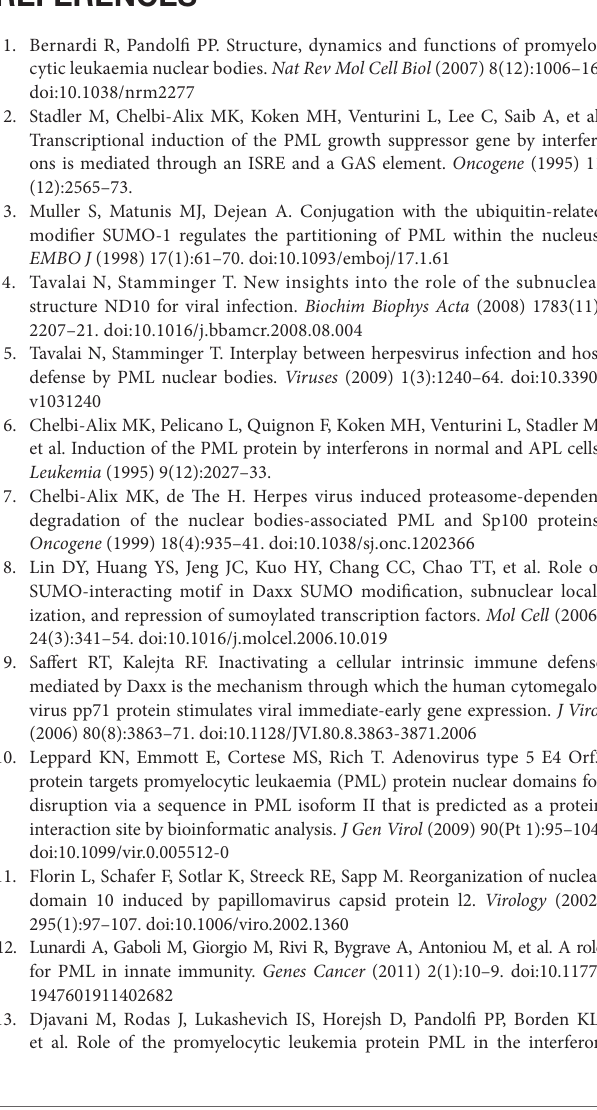
FigUre s1 | EV71 VP1 synthesis in infected cells overexpressing individual PML isoforms. (a) Expression of individual PML isoforms in PML − / − HeLa cells transfected with plasmids expressing FLAG-PMLI, FLAG-PMLII, FLAG-PMLIII, FLAG-PMLIV, FLAG-PMLV, or FLAG-PMLVI as revealed by Western blotting using anti-FLAG and anti-GAPDH antibodies. (B) PML − / − HeLa cells transfected with plasmids expressing each PML isoform were infected with EV71 at an MOI of 5 for 24 h. The extracts from these cells, i.e., non-infected ( − ) or infected ( + ), were analyzed by performing a Western blot analysis using anti-VP1 and anti-GAPDH antibodies. FigUre s2 | Immunofluorescence analysis of infected cells expressing individual PML isoforms. HeLa cells transfected with an empty vector (pEGFP-C1) or a plasmid expressing EGFP-PMLI, EGFP-PMLII, EGFP-PMLIII, EGFP-PMLIV, EGFP-PMLV, or EGFP-PMLVI were infected with EV71 at an MOI of 5 for 12 h. A double immunofluorescence analysis was performed using a monoclonal antibody specific for VP1 (red) and GFP-PMLI and GFP-PMLVI (green). The samples were examined under a fluorescence microscope, and the images were analyzed under an Olympus FluoView FV10i confocal microscope (Tokyo, Japan). FigUre s3 | Western blot analysis of uninfected or infected cells expressing VP1 and LC3-I and II in siATG5-treated or siNC-treated cells. HeLa WT cells